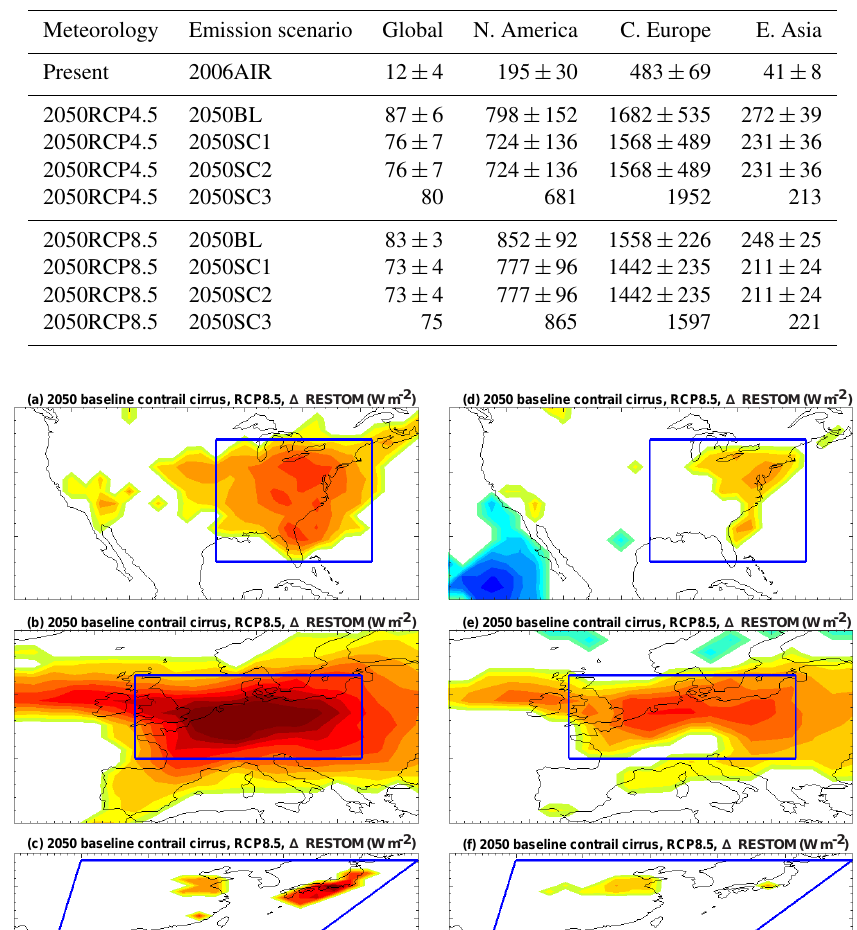
Table 3. Radiative forcing (mWm − 2 ) due to aviation H 2 O emissions. The uncertainties are based on 2 standard deviations of the four- member ensemble.